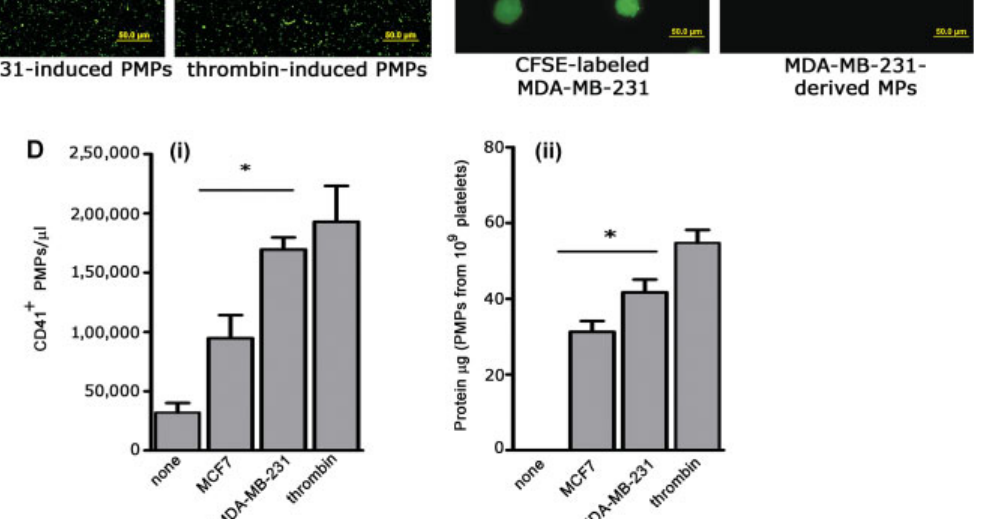
TH Open Vol. 1 No.